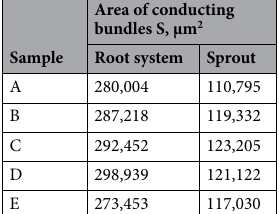
Table 3. Average area of conducting bundles of the root system and sprout, p <